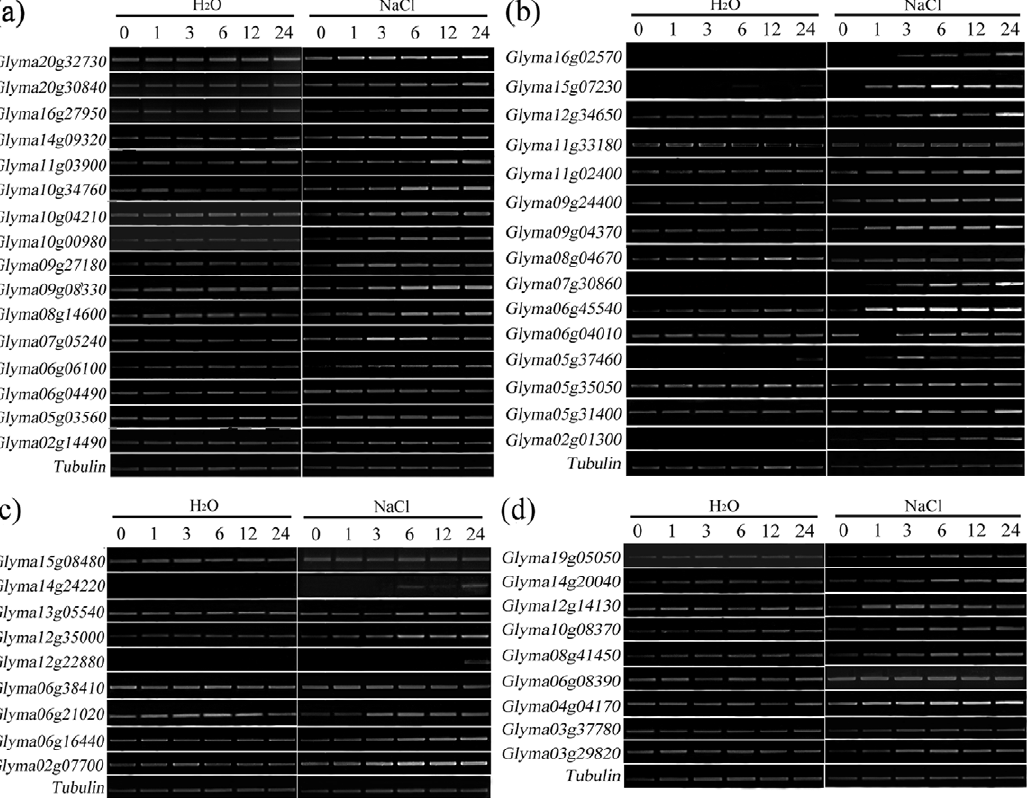
Figure 1. The expression of the 49 TFs in mock-stressed and salinity-stressed seedlings. (a) GmAP2-DREBs , (b) GmMYBs , (c) GmNACs and (d) Gmb-ZIPs . M0-M24 refer to seedlings exposed to just ddH 2 O for, respectively, 0h, 1h, 3h, 6h, 12h and 24h; S0–S24 refer seedlings exposed to 150 mM NaCl for 0h, 1h, 3h, 6h, 12h and 24h, respectively. Each gene-specific region was amplified by RT–PCR using the gene-specific primers (Table S2). The TUBULIN gene (Genbank accession AY907703) was used as an internal control. The experiment was repeated three times with similar result.